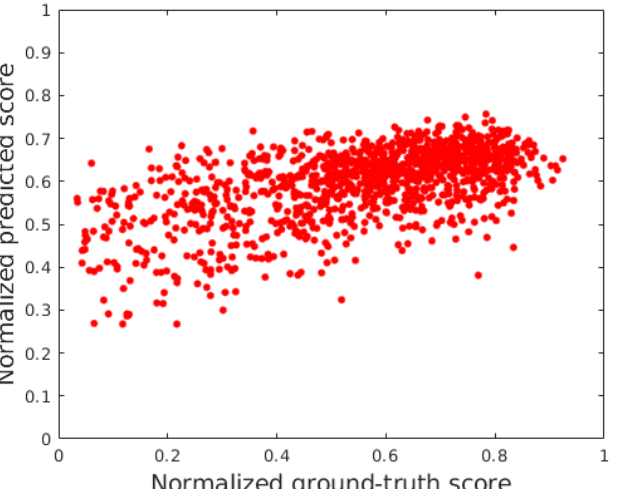
Figure 7. Normalized ground truth scores versus normalized predicted score scatter plot of FLG-IQA in the cross-database